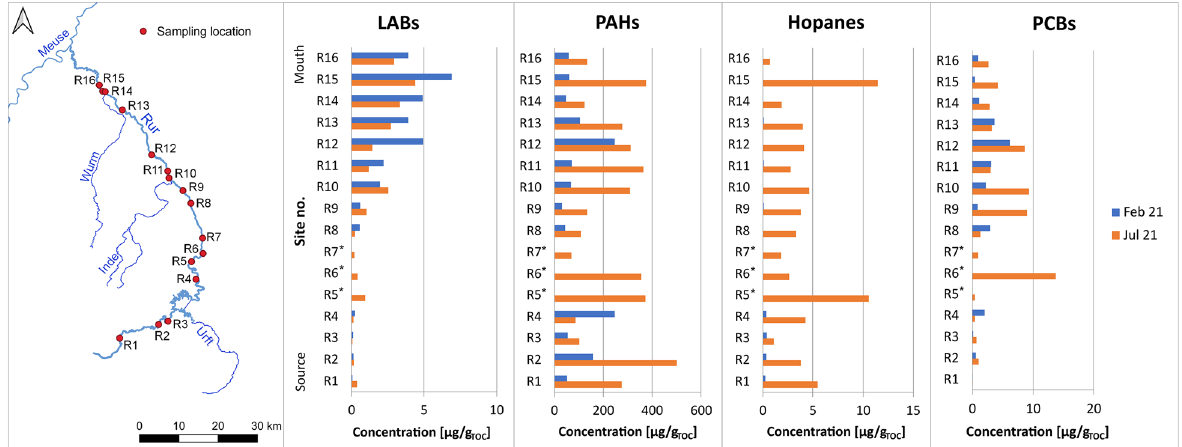
Fig. 2 Spatial distribution of LABs, PAHs, hopanes and PCBs over the Rur River course. Samples have been taken after two flood events in January/ February and July 2021. (*) R5 to R7 were not sampled in